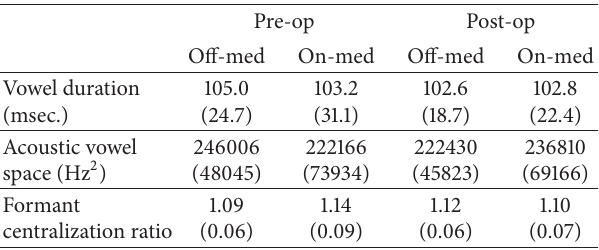
Table 2: Means (standard deviations) for vowel duration (msec.), acoustic vowel space (Hz 2 ), and formant centralization ratio before and after STN DBS, off- and